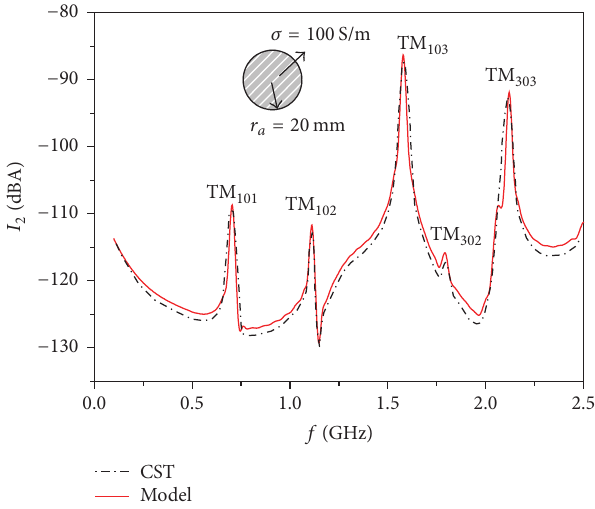
covered circular aperture from the analytical model and the CST.